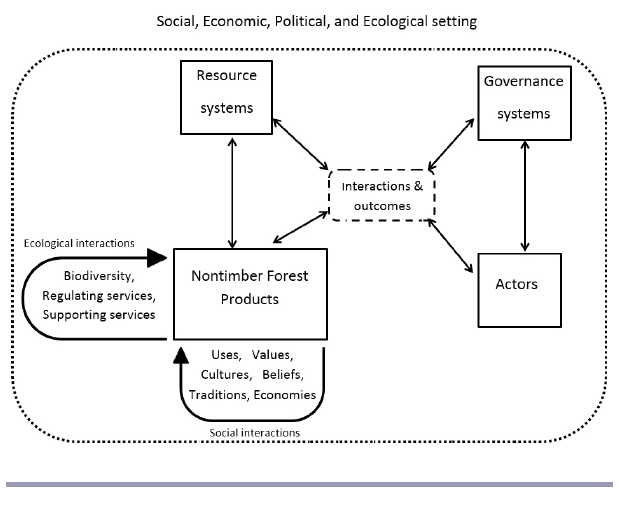
Fig. 1 . Nontimber forest products (NTFPs) in social-ecological systems. Figure adapted from McGinnis and Ostrom (2014) by replacing “resources units” with NTFPs. The original does not delineate interactions within the four domains (only between them). Here we illustrate how the within interactions, i.e., use of and interactions between NTFP species, affects other NTFPs and uses, i.e., the biocultural keystone